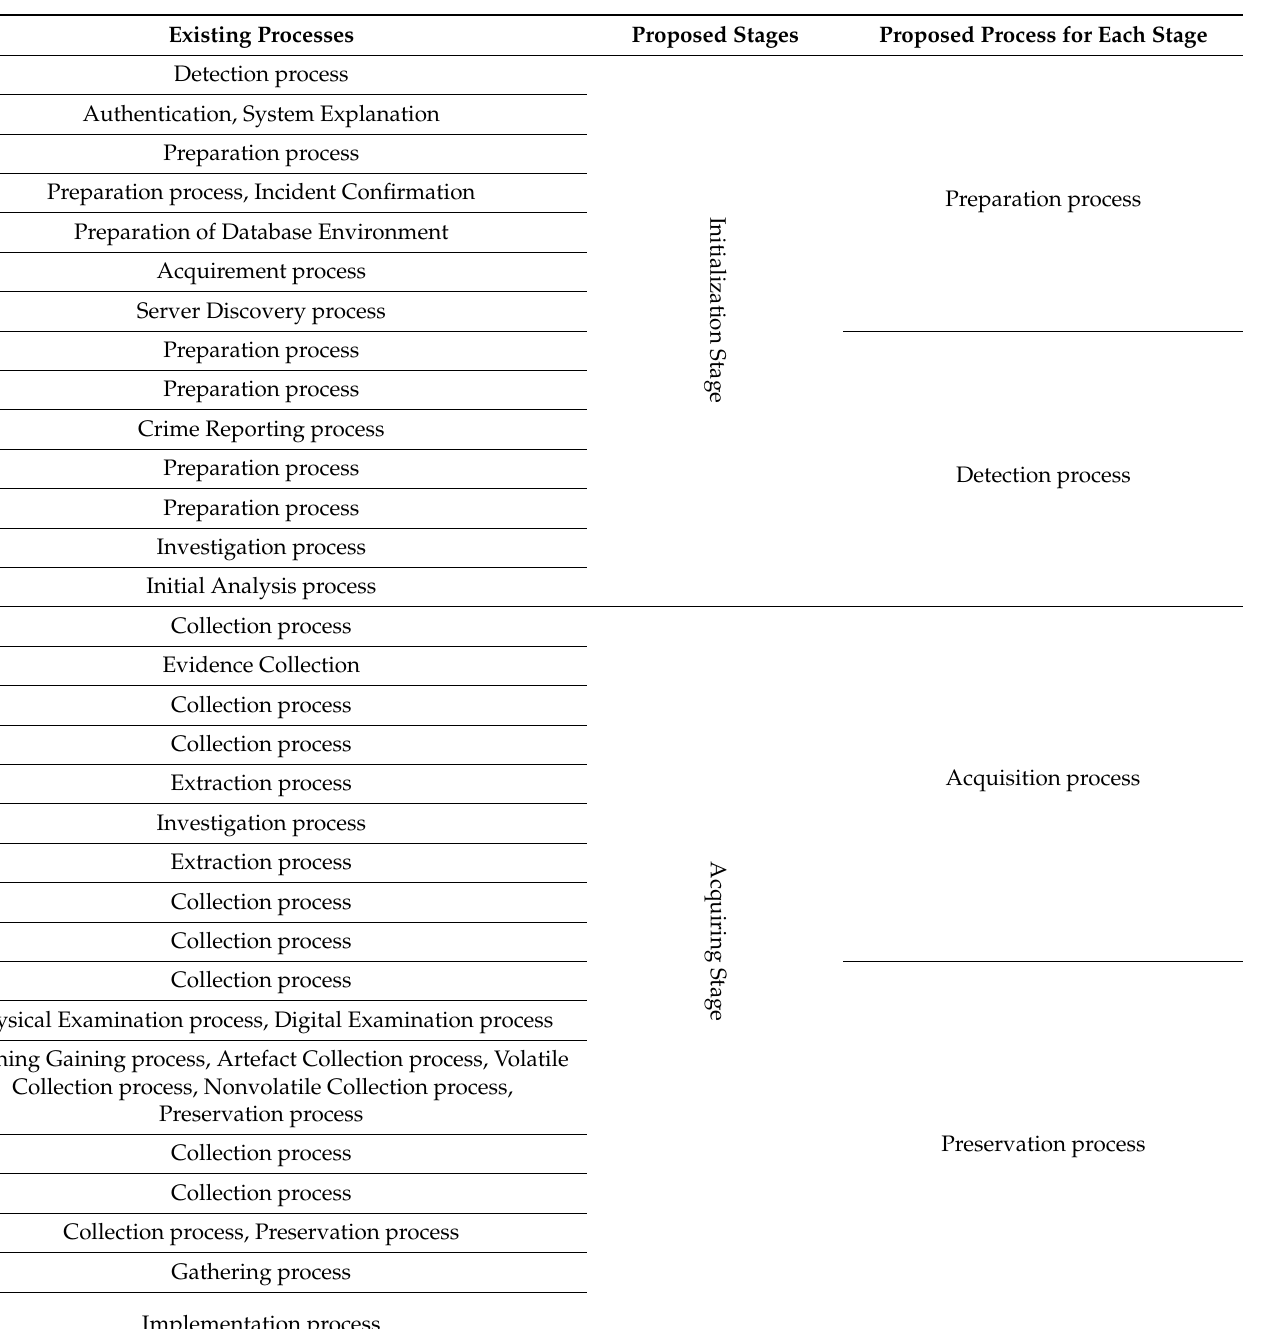
Table 2. Proposed investigation stages for